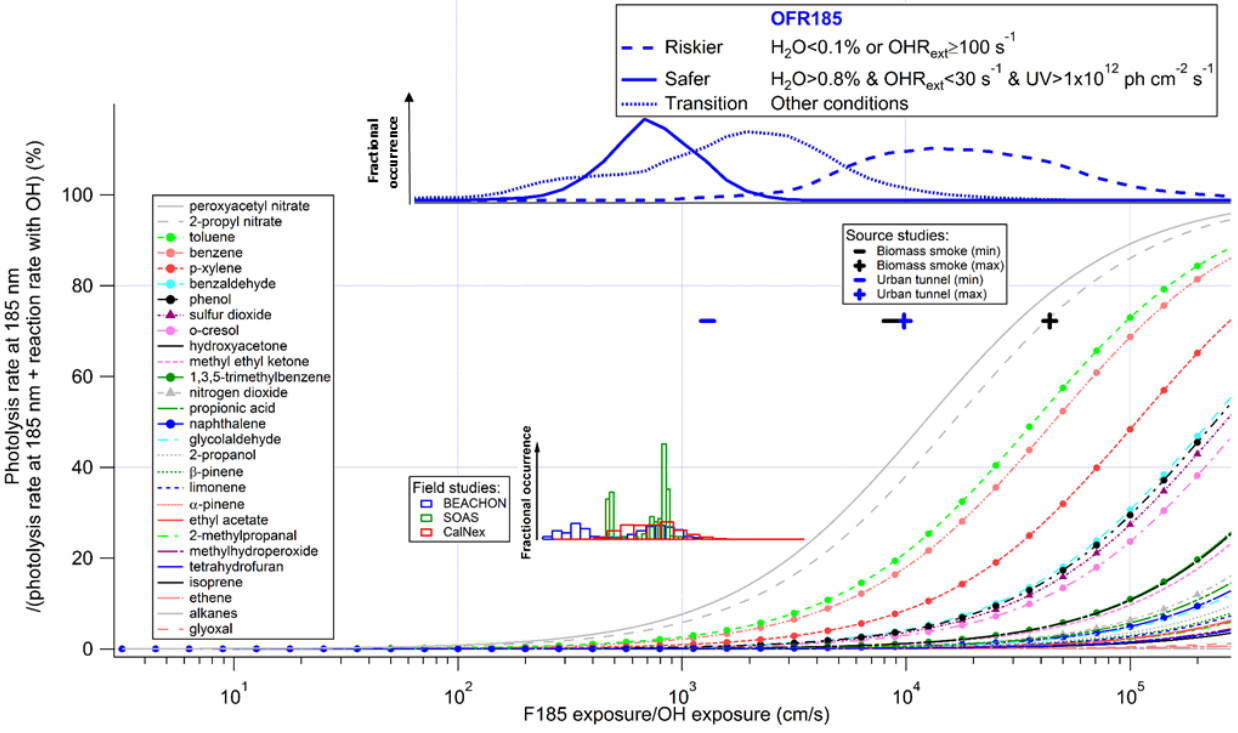
Figure 1. Fractional importance of the photolysis rate at 185nm of several species of interest vs. the reaction rate with OH, as a function of the ratio of exposure to 185nm photons (F185) and OH. F185 exposure (in photonscm − 2 ) is the product of 185nm photon flux (in photonscm − 2 s − 1 ) and time (in s). F185 exposure / OH exposure is thus in cms − 1 . The modeled frequency distributions of ratios of 185nm photon exposure to OH exposure under riskier, safer, and transition conditions for OFR185 are also shown. The curves of aromatics and inorganic gases are highlighted by solid dots and upward triangles, respectively. The lower inset shows histograms of model-estimated F185 / OH exposures for three field studies where OFR185 was used to process ambient air. Their ordinate is the fractional occurrence of a given condition (X exp / OH exp ). All histograms are normalized to be of identical total area (i.e., total probability of 1). The upper inset (black and blue markers) shows similar information for source studies of biomass smoke (FLAME-3; Ortega et al., 2013) and an urban tunnel (Tkacik et al., 2014). All curves, markers, and histograms in this figure share the same